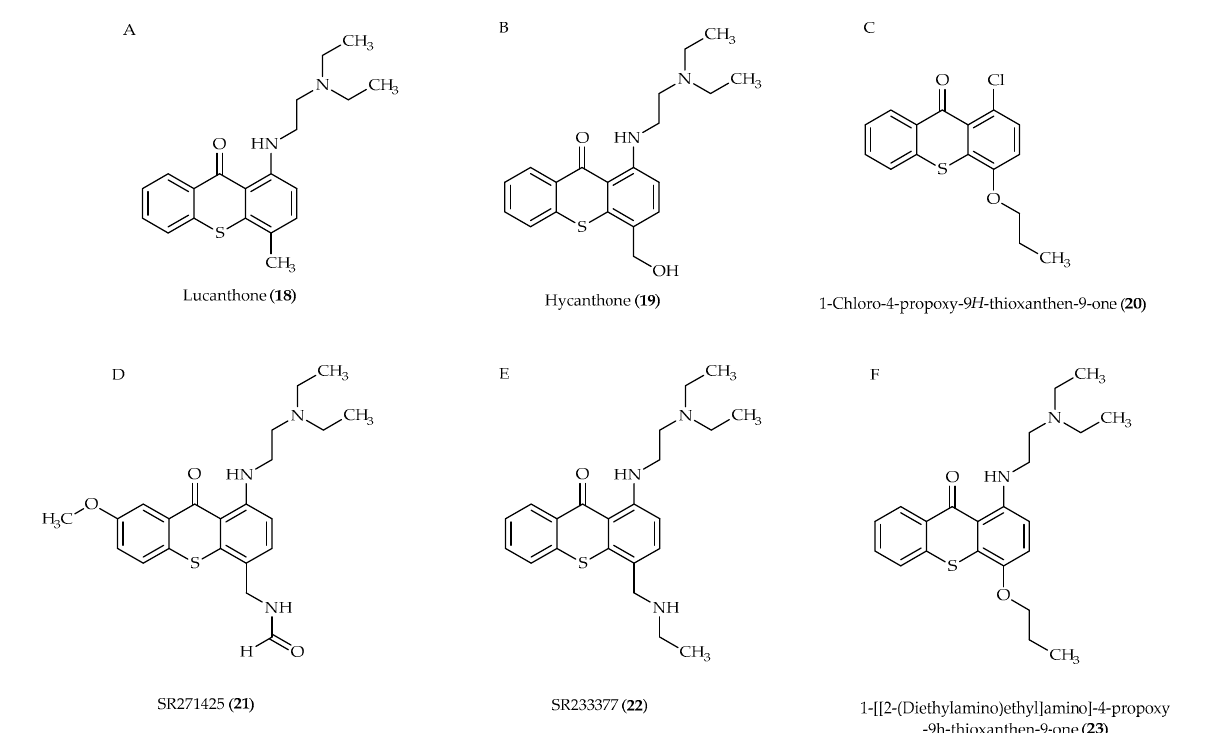
Figure 9. Chemical structures of thioxanthones.